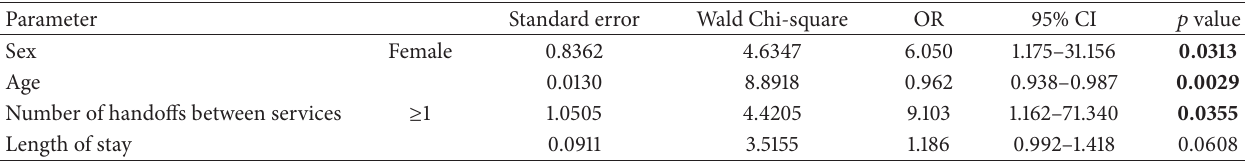
Table 3: Analysis of maximum likelihood